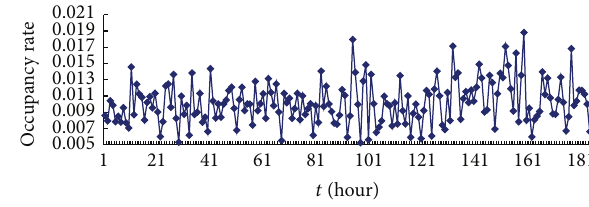
Figure 6: Band occupancy rate data of interphone